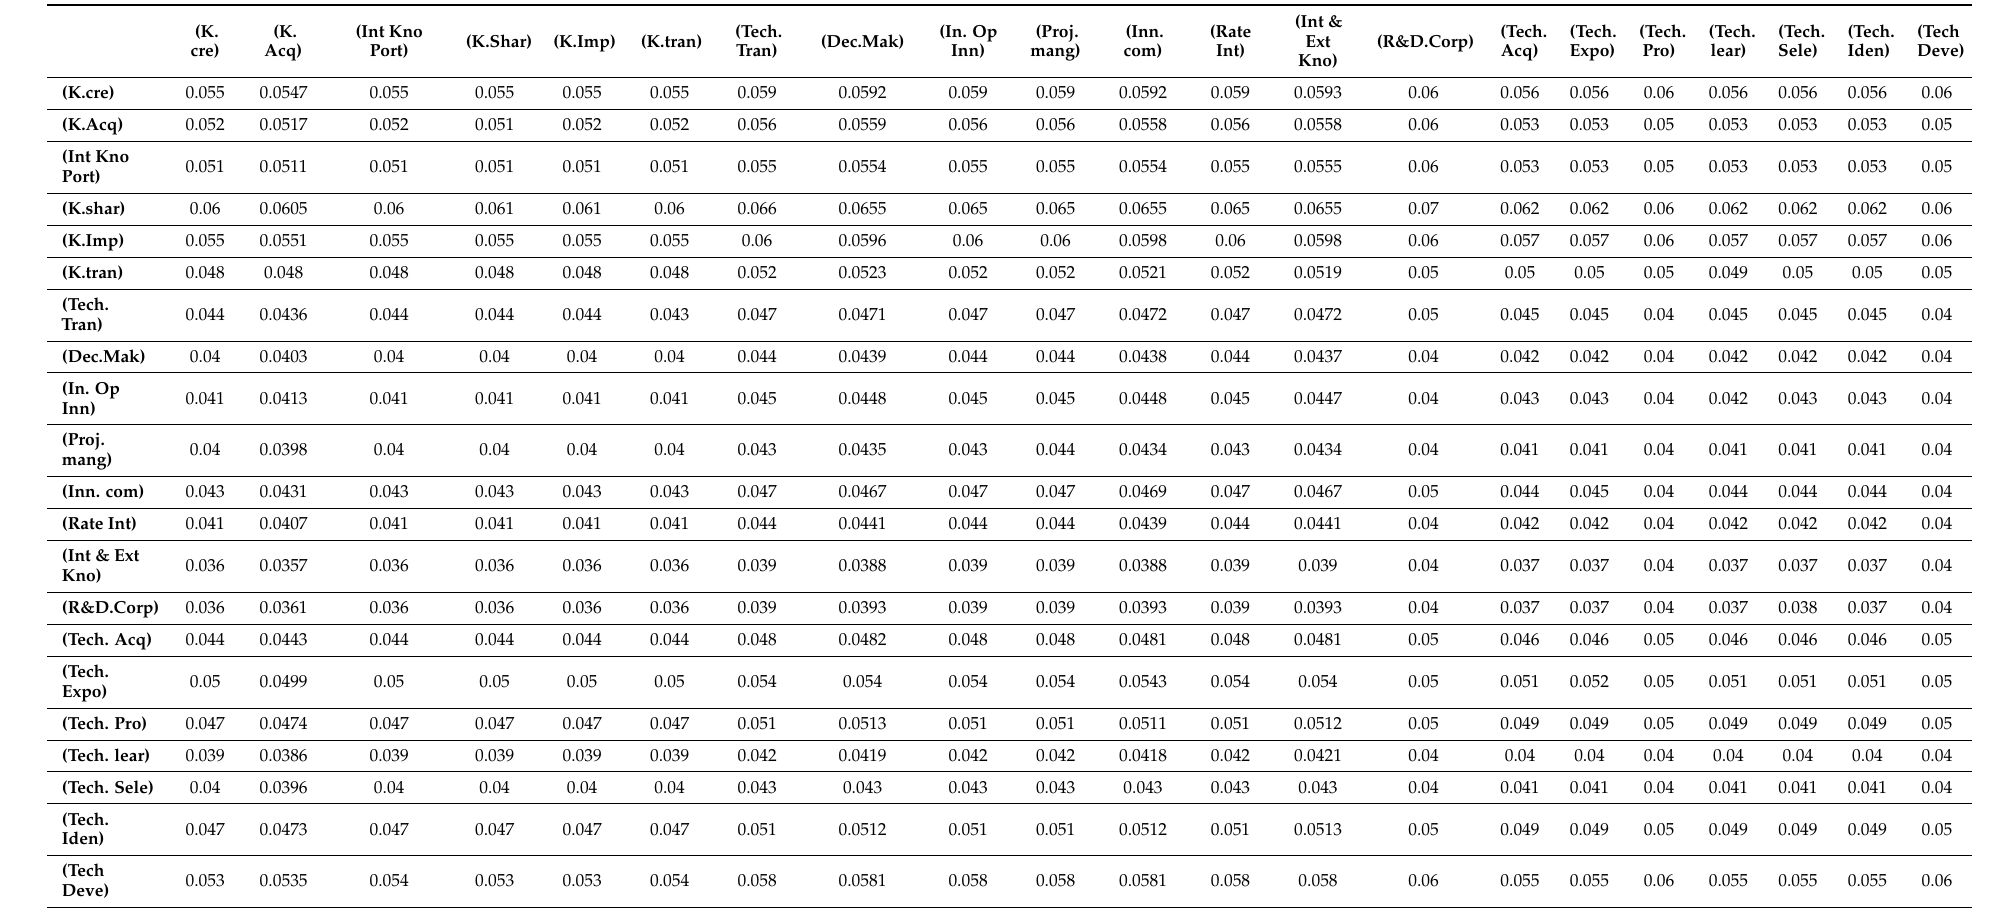
Table 12. Weighted super matrix W